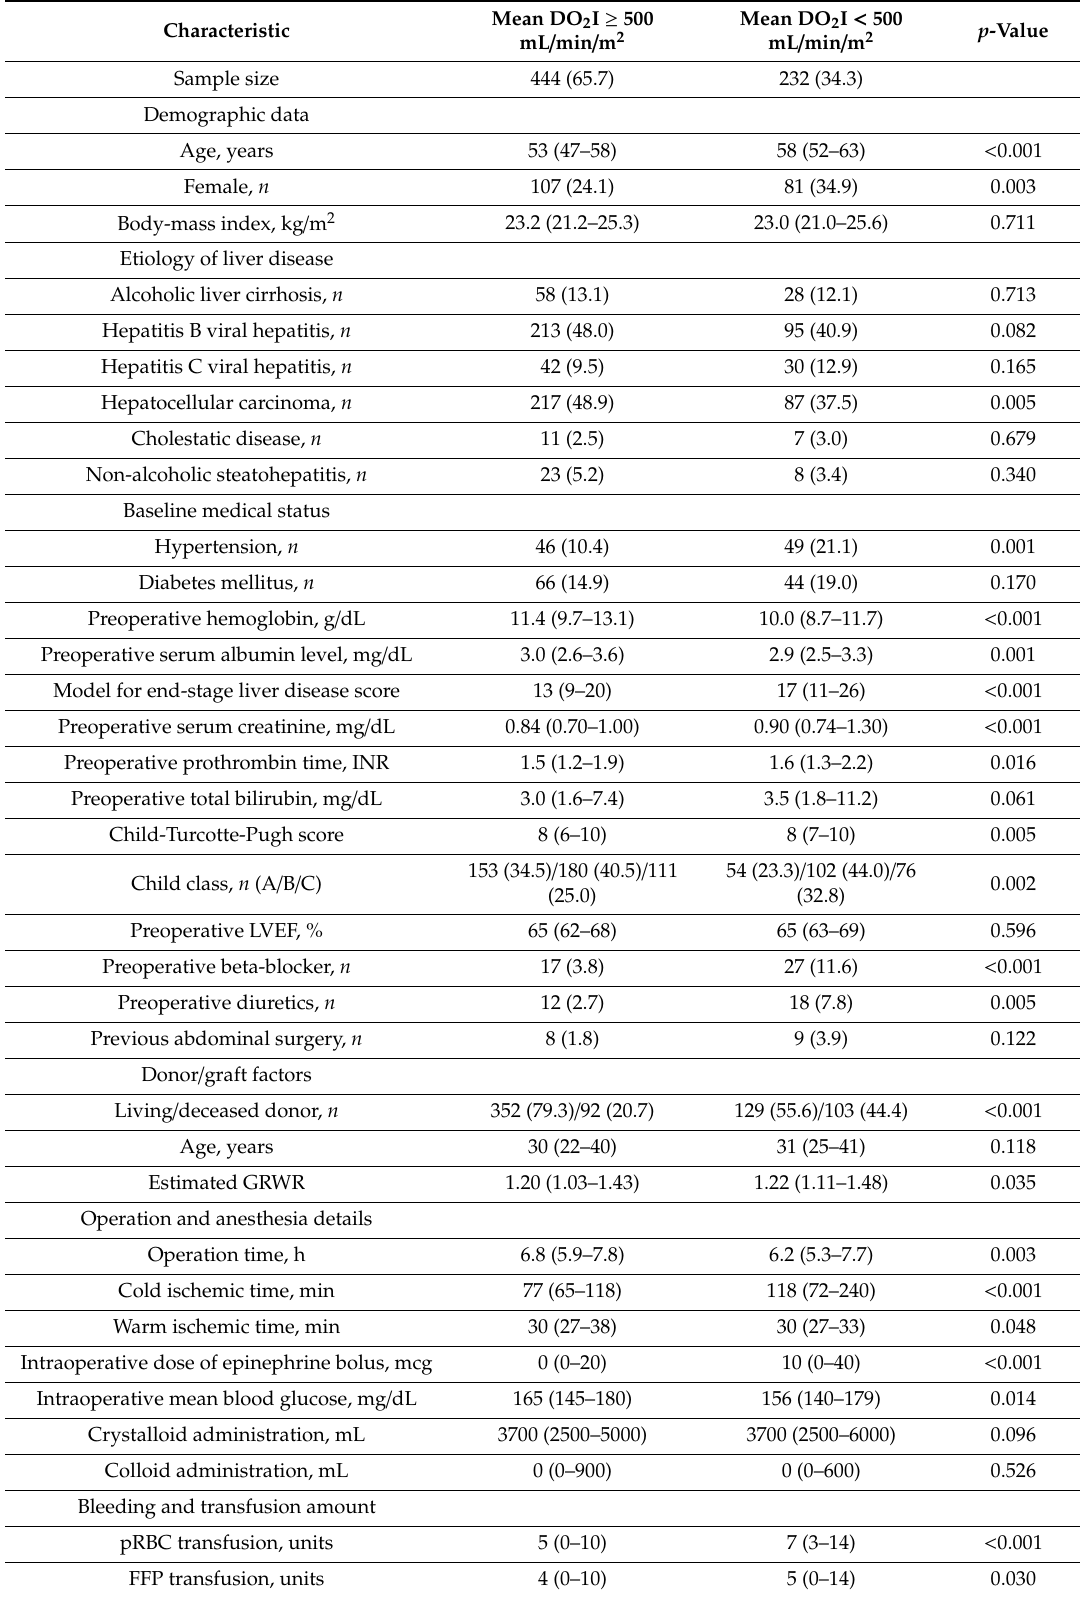
Table 1. Patient characteristics and perioperative parameters of the patients with a high and low mean oxygen delivery index (mean DO 2 I) during liver